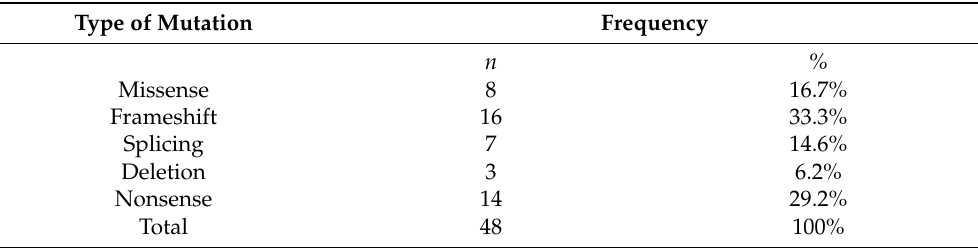
Table 5. Frequencies of different types of genetic mutations responsible for the disease, collected in 48